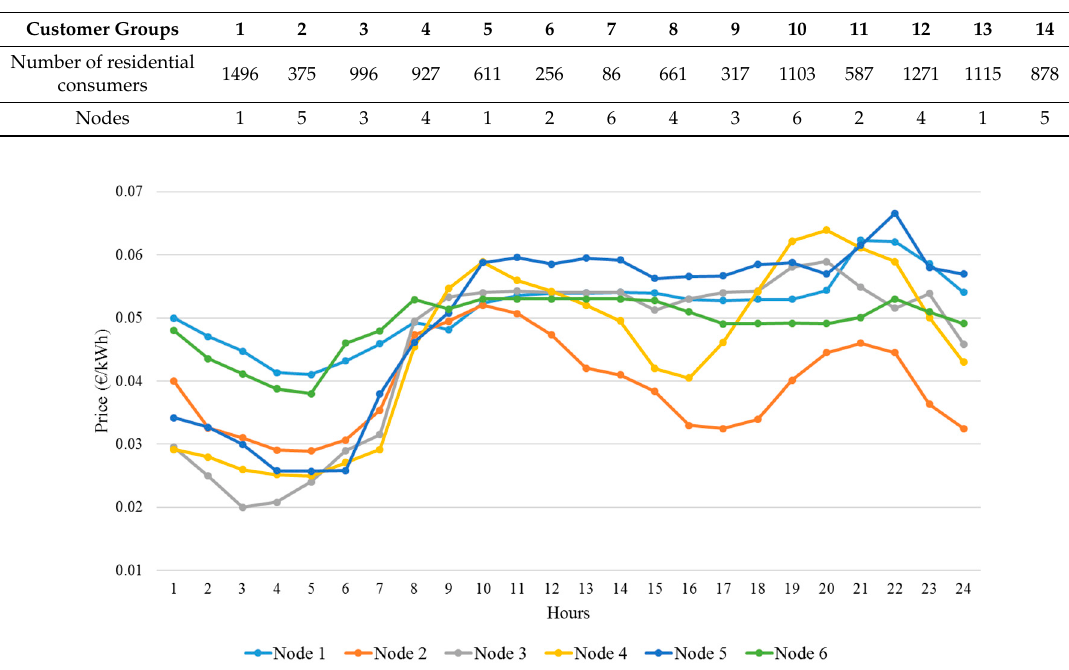
Figure 5. Forecasted wholesale market price at nodes.